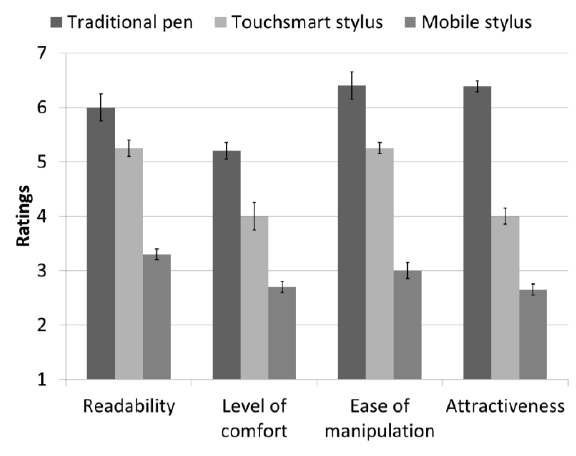
Figure 5. Average ratings (high values are